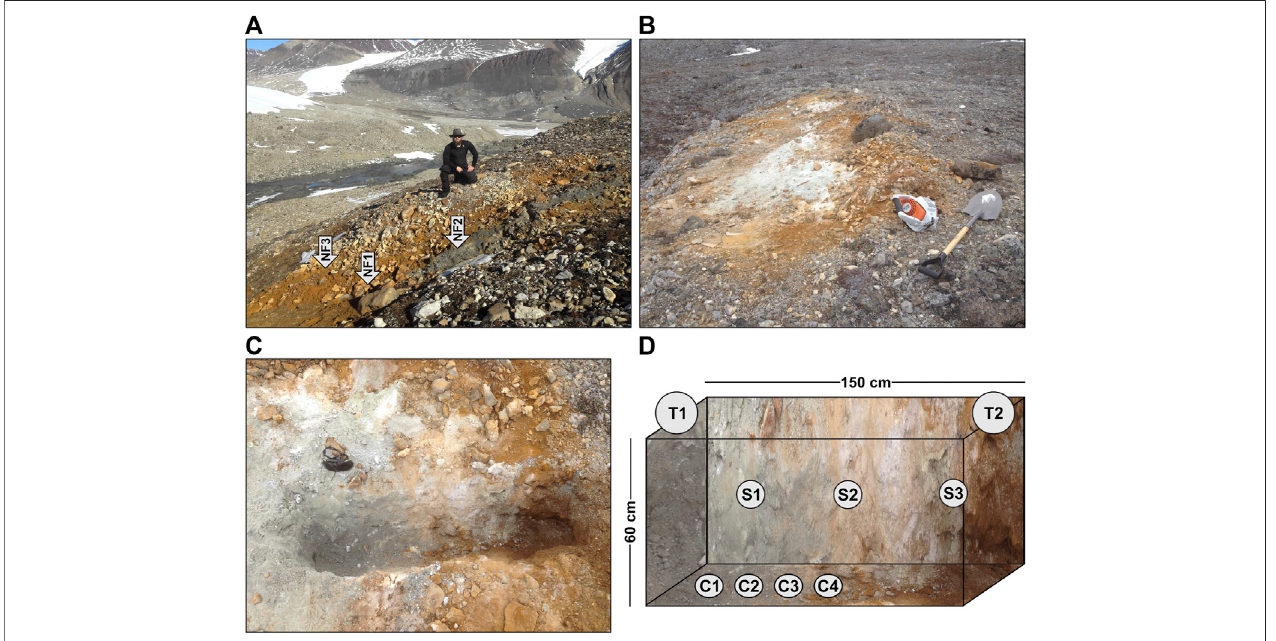
FIGURE 2 | Mineral alteration features and sampling locations. Samples were collected from the features labeled as North Feature (NF; A ) and South Feature (SF; B ). Samples NF1, NF2, and NF3 are labeled in (A) (with author GL for scale). For site SF, a shovel and core drill (shown in B ) were used to dig a trench and take samples from the permafrost (C) . Goggles are shown in (C) for scale. The locations of samples collected from this feature are shown in a representation of the trench in (D) . Sample names from the trench samples are included. Approximate lengths along the long axes of the features in (A) and (B) are 4